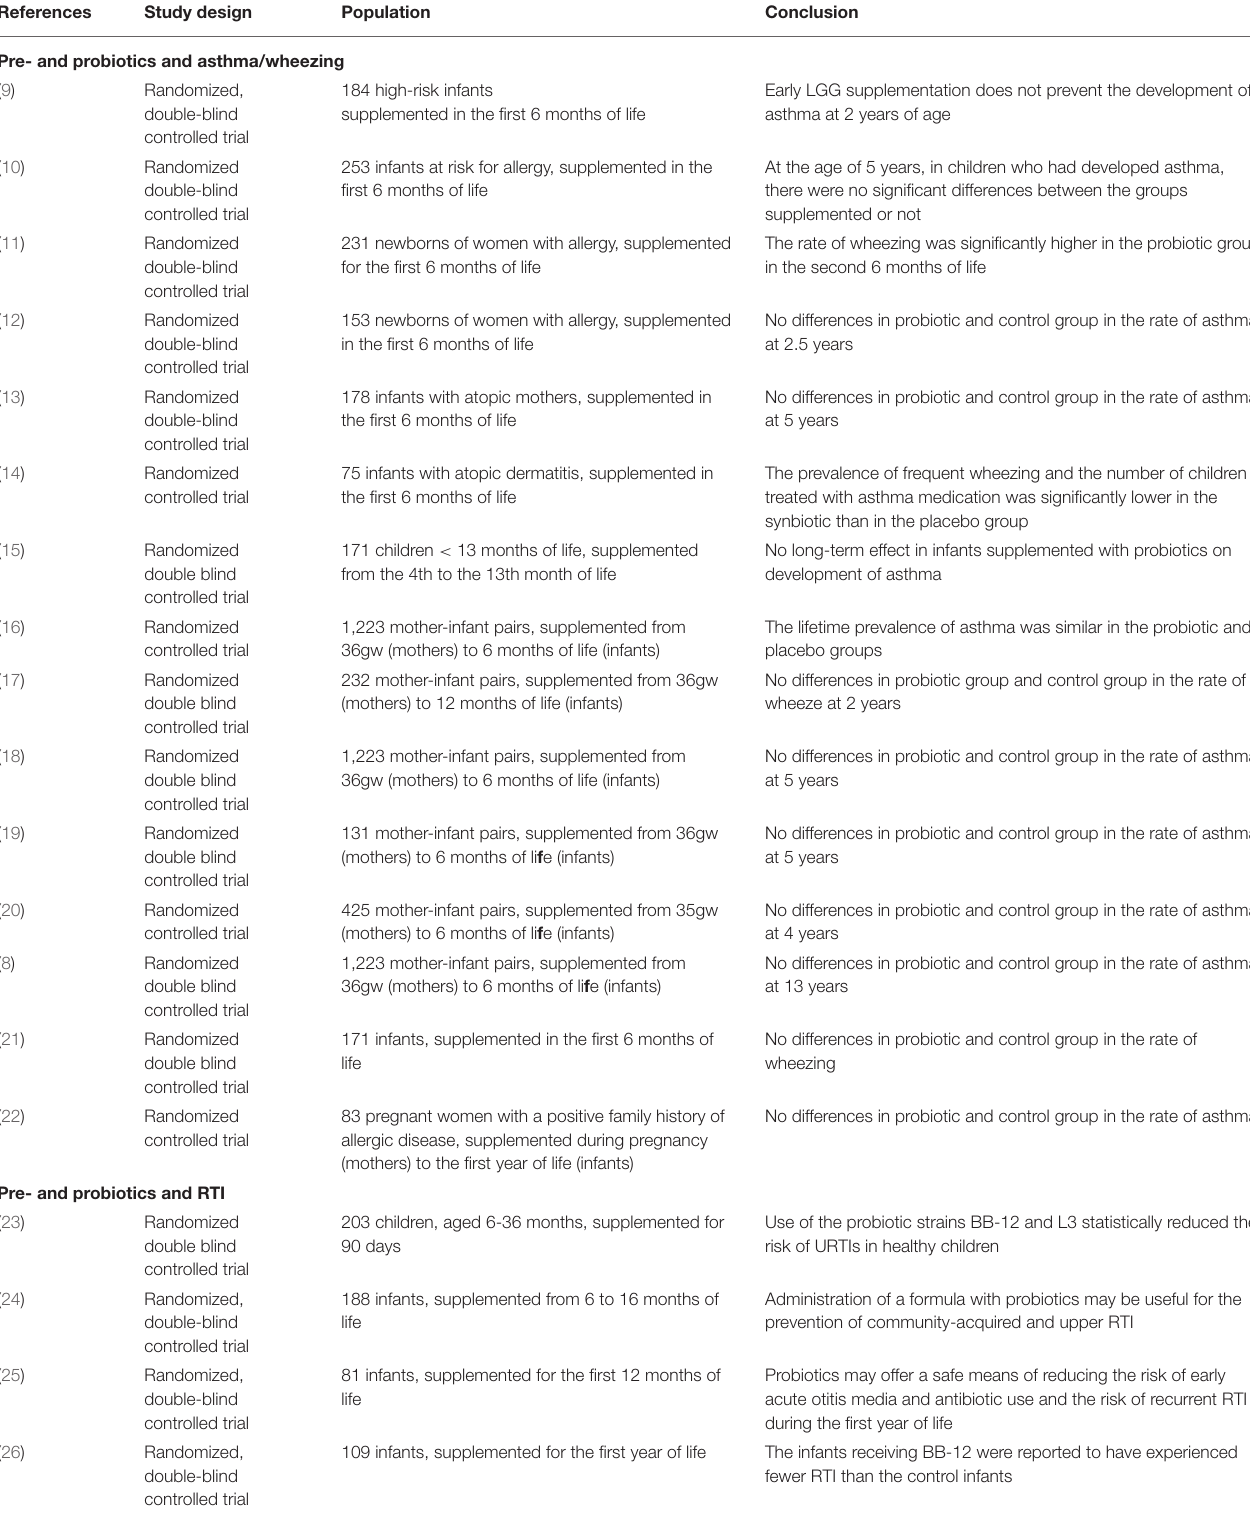
TABLE 1 | Main features and results of studies investigating active supplementation of pre- and